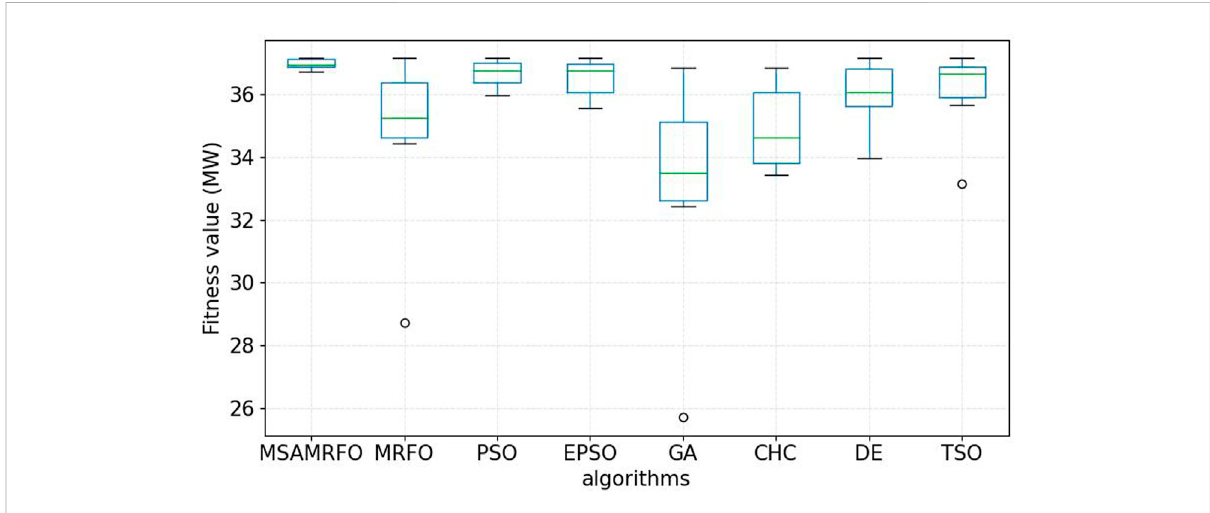
FIGURE 6 Box-and-Whisker plot of different